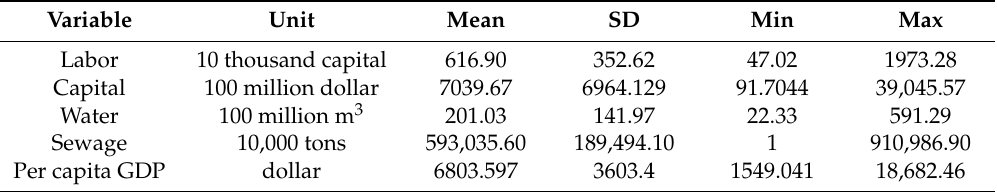
Table 2. Descriptive statistics of the water use efficiency evaluation index from 2008–2016 in China. Variable Unit Mean SD Min Max Labor 10 thousand capital